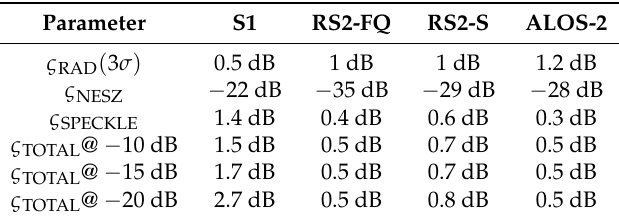
Table 3. Signal-noise budget associated with data from different sensors and modes for 90 by 90 m spatially resampled SAR signals, with total noise computed for three backscatter intensity scenarios. Radiometric stability and NESZ values were extracted from sensor and product descriptions